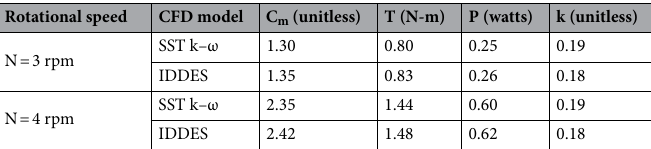
Table 2. Computation of the slippage factor k